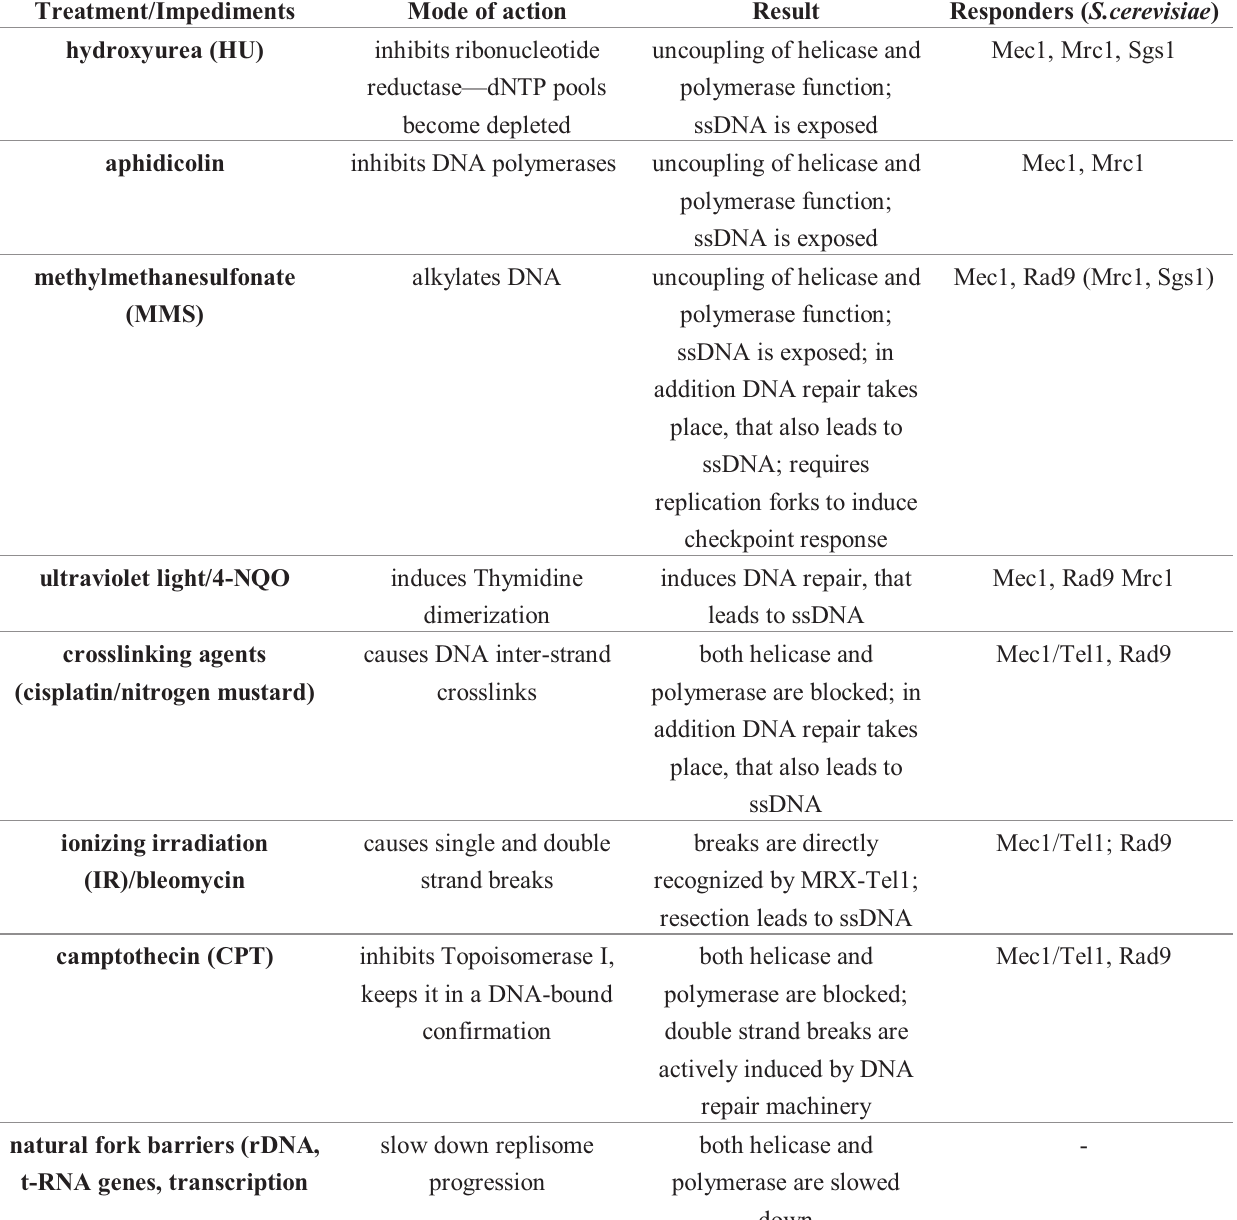
Table 2. S. cerevisiae checkpoint responses differ, depending on the